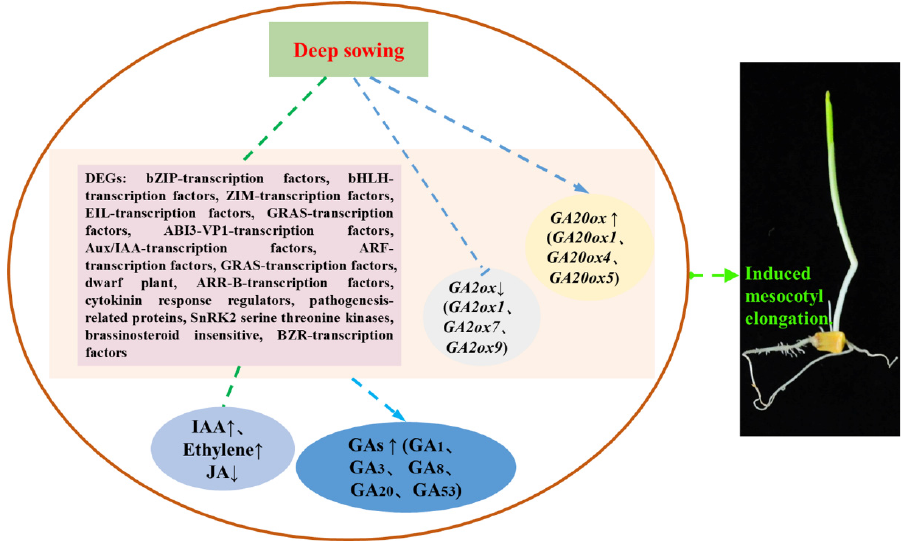
Figure 8. Molecular network of hormones in mesocotyl response to deep ‐ sowing stress in sweet maize.